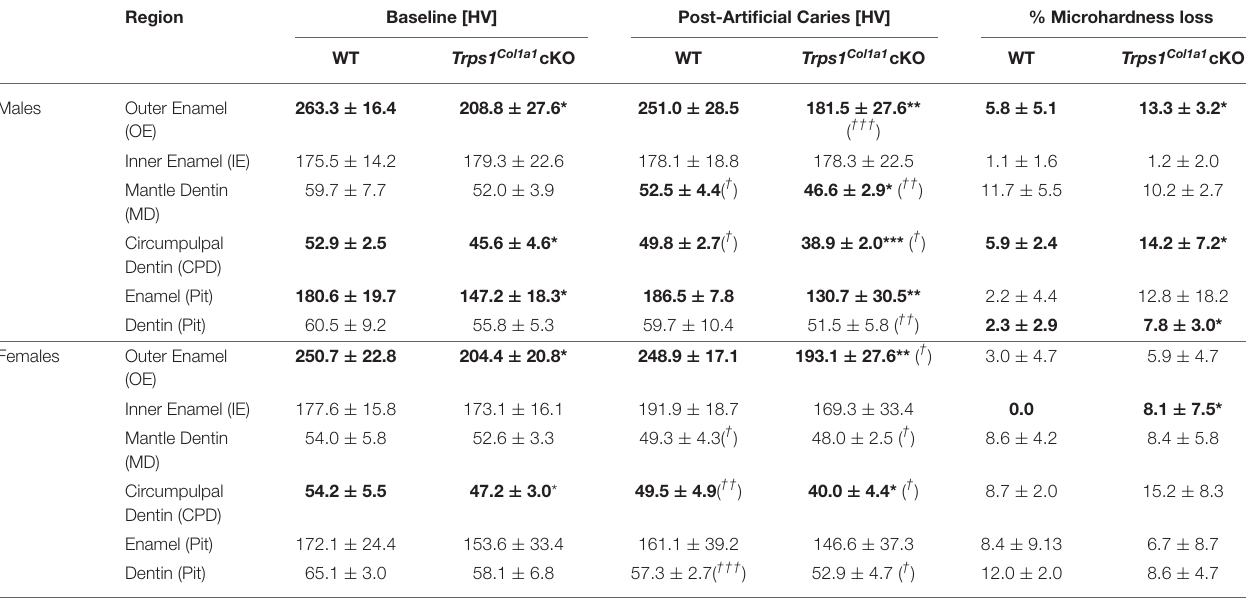
TABLE 1 | Summary of Vickers microhardness analyses and effect of artificial caries procedure on tissue microhardness loss in WT and Trps1 Col1a1 cKO mandibular first